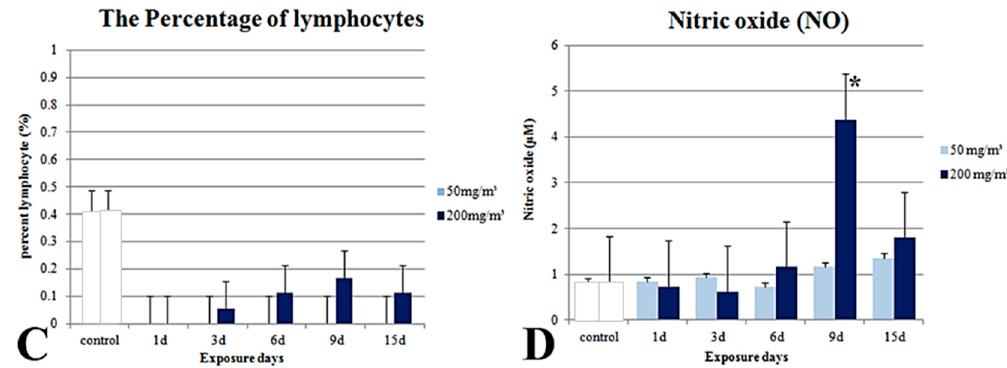
Figure 9. Cellular and biochemical parameters of the bronchoalveolar lavage fluid. Total cell numbers ( A ); The percentage of neutrophils ( B ); The percentage of lymphocytes ( C ); Nitric oxide (D). d: day, * significantly different from the control group, p < 0.05.